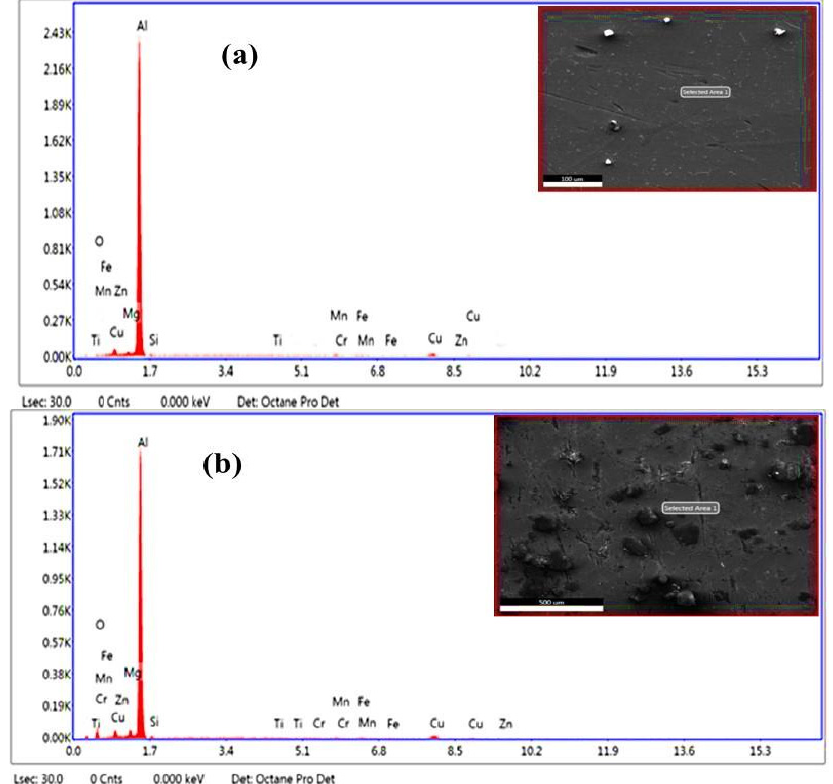
Figure 2. ( a , b ). EDS spectrum of ( a ) Al2014 after T6 treatment; ( b ) Al2014-15 wt.% Al 2 O 3 MMCs after T6 treatment.